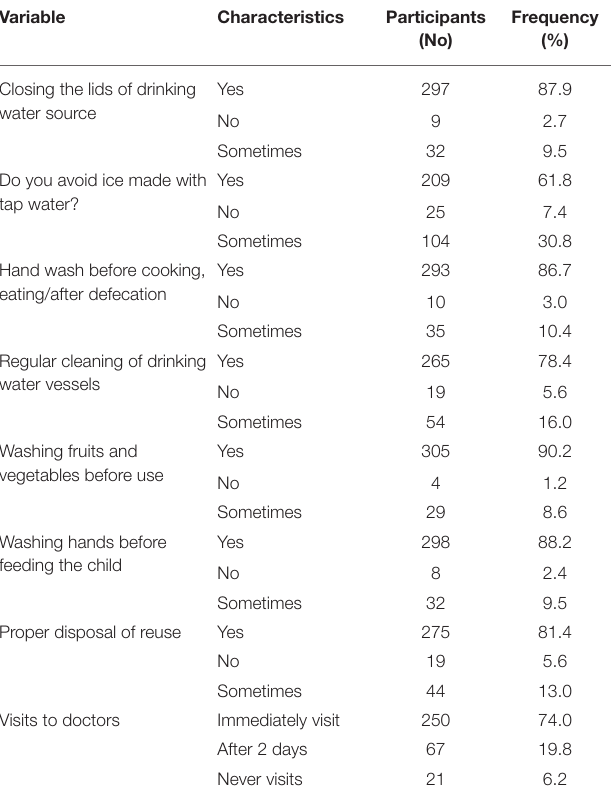
TABLE 5 | One-health toward diarrhea of participants in the study.